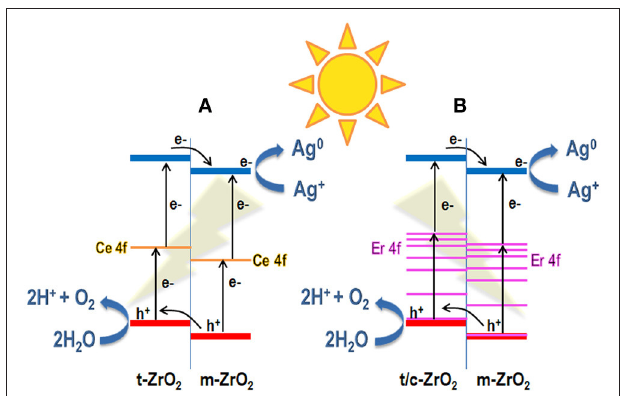
FIGURE 10 | Schema of solar-driven photocatalytic water oxidation in the presence of Ag + as electron scavenger under sunlight illumination over the Ce-doped ZrO 2 (A) and Er-doped ZrO 2 (B) samples, where it is evident the enhanced charges separation due to the presence of two ZrO 2 polymorphs (i.e., tetragonal or cubic and monoclinic